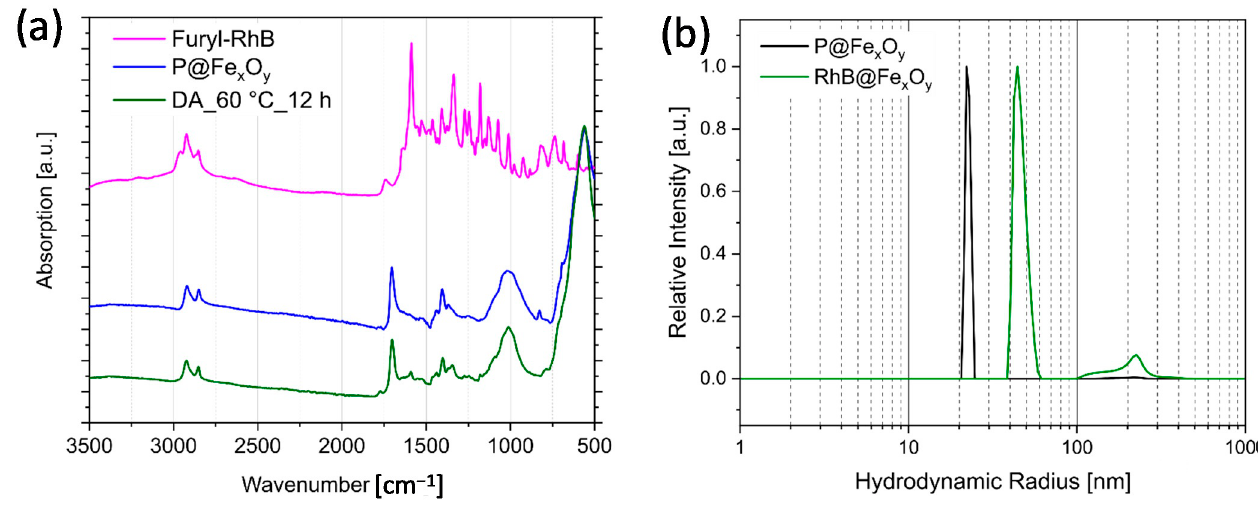
Figure 7. ( a ) ATR FTIR spectra of furfuryl-modified rhodamine b, phosphonate-modified Fe x O y nanoparticles, and the DA product of both; ( b ) DLS of the particles before and after DA modification in EtOH.